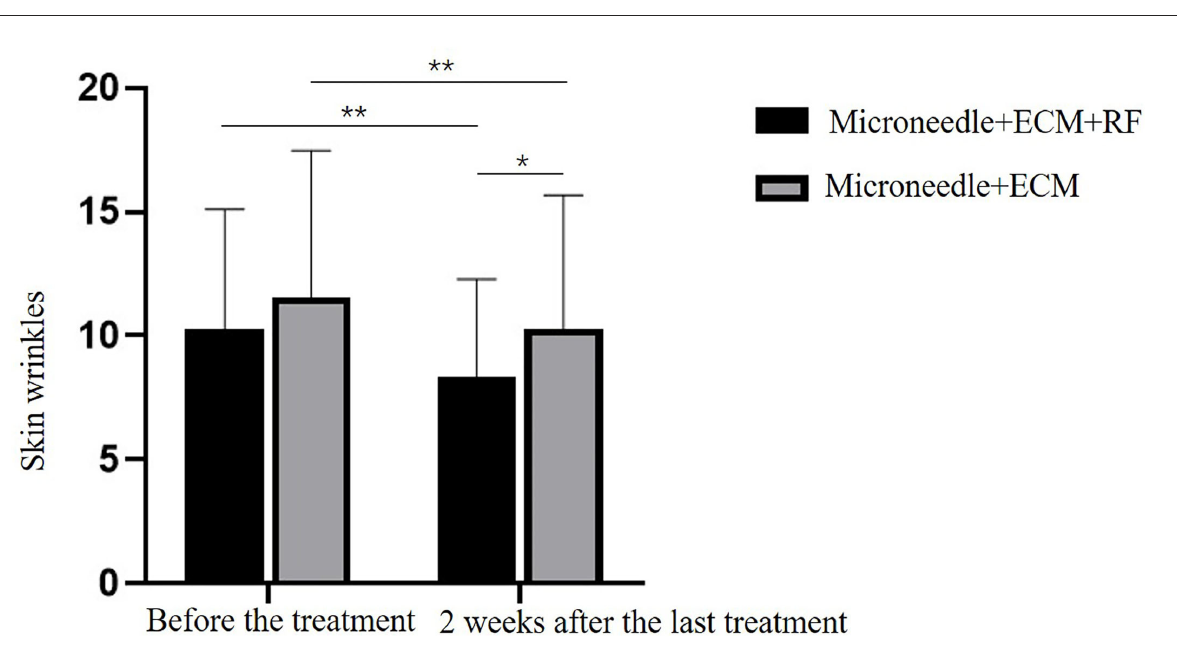
weeks after the last